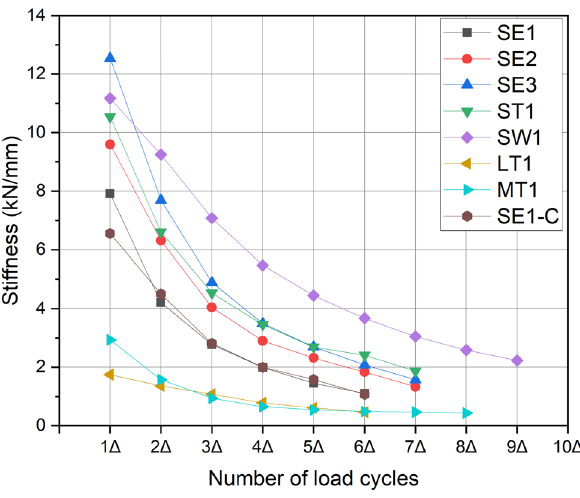
Figure 13: Sti ff ness degradation curve of typical